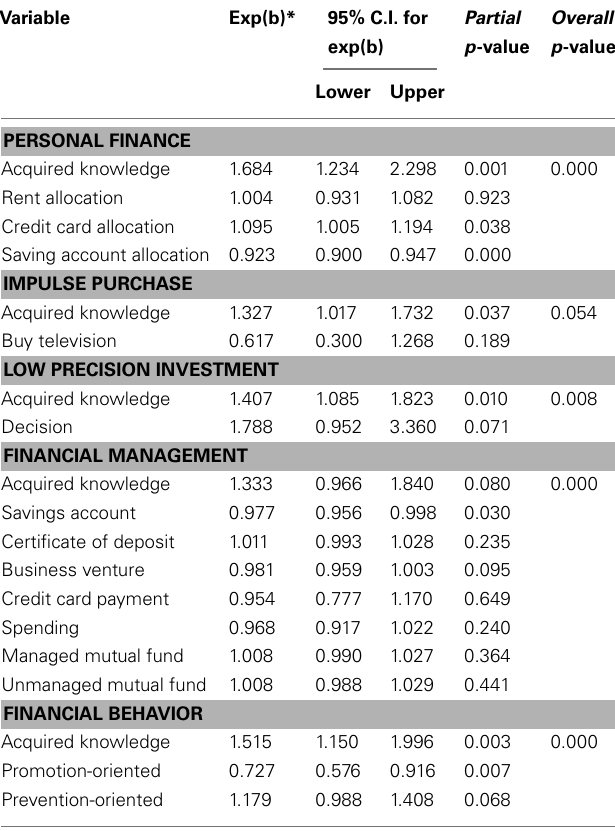
Table 1 | Logistic Regression Models of FDMQ Scenarios toAge (i.e., Younger vs.